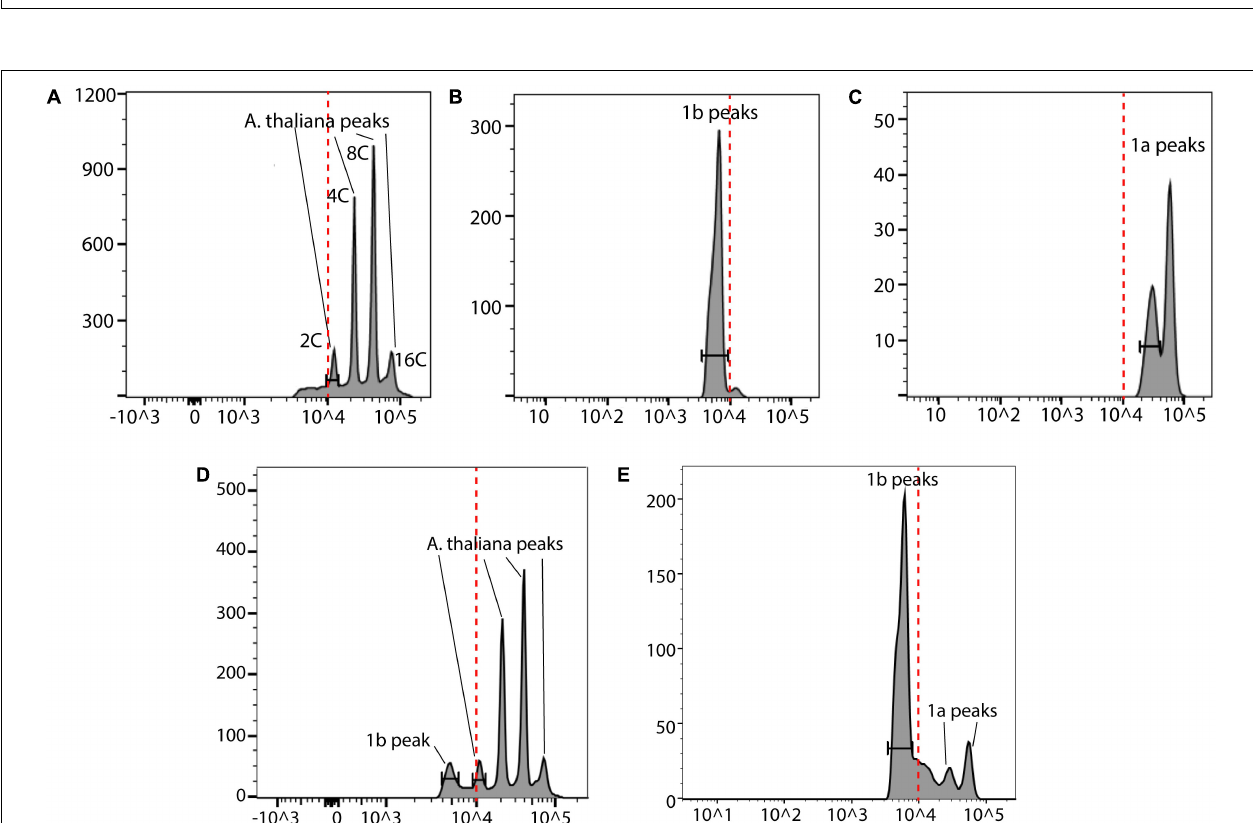
FIGURE 9 | Flow cytometry analysis of SAG 698-1a and SAG 698-1b. (A) Cell cycle G1 phase nuclei of A. thaliana ; (B) Cell cycle G1 phase nuclei of SAG 698-1b; (C) Cell cycle G1 phase nuclei of SAG 698-1a; (D) Cell cycle G1 phase mixed nuclei of A. thaliana and SAG 698-1b; (E) Cell cycle G1 phase mixed nuclei of SAG 698-1a and SAG 698-1b. X -axis is the fluorescence intensity representing the relative nuclear DNA content, and Y -axis is the channel bins representing the count of nuclei. Red dash lines indicate the fluorescence intensity at 10 4 .